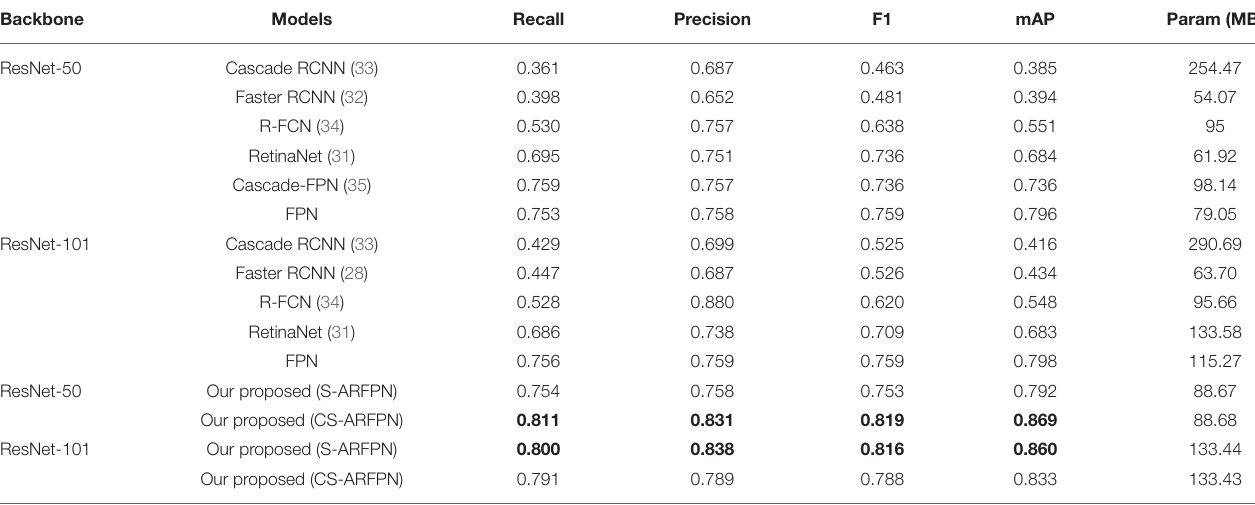
TABLE 7 | Comparison of our proposed method with other advanced methods. Backbone Models Recall Precision F1 mAP Param (MB) ResNet-50